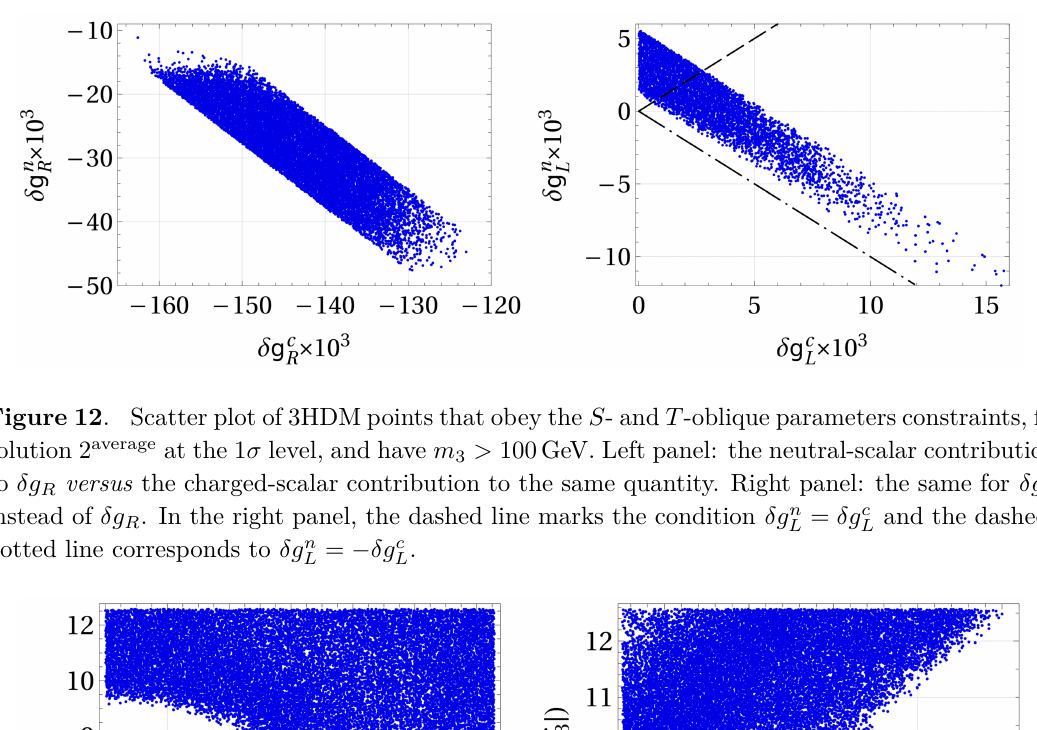
L = δg c and the dashed- L L